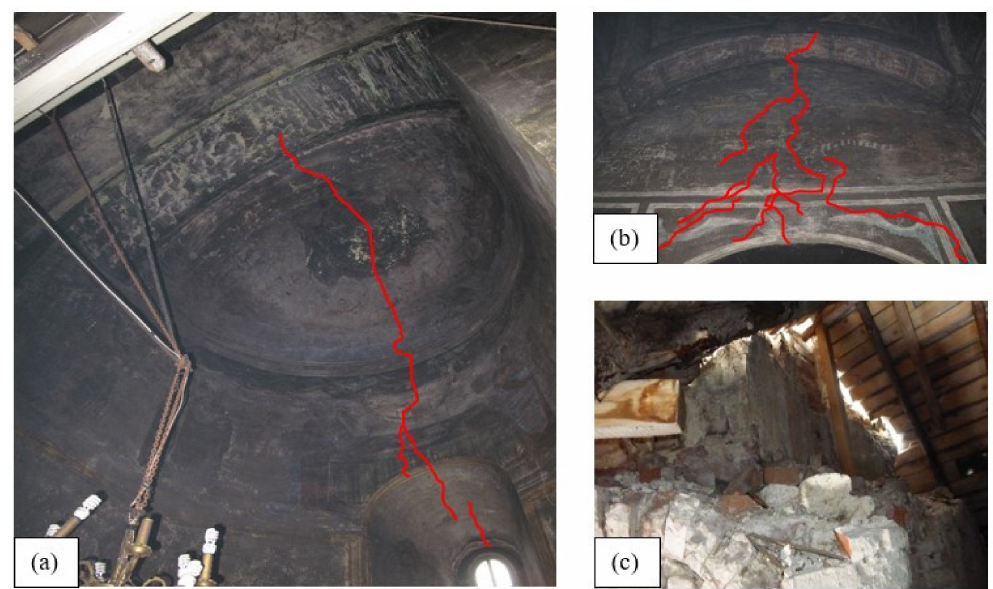
Figure 3. Visual investigations: ( a ) Continuous cracks between the window and the vault keystone— Sanctuary, ( b ) Cracks in the transition arch from the entrance in the narthex, ( c ) Degradations located both in the masonry and the nearby roof timber framing system.